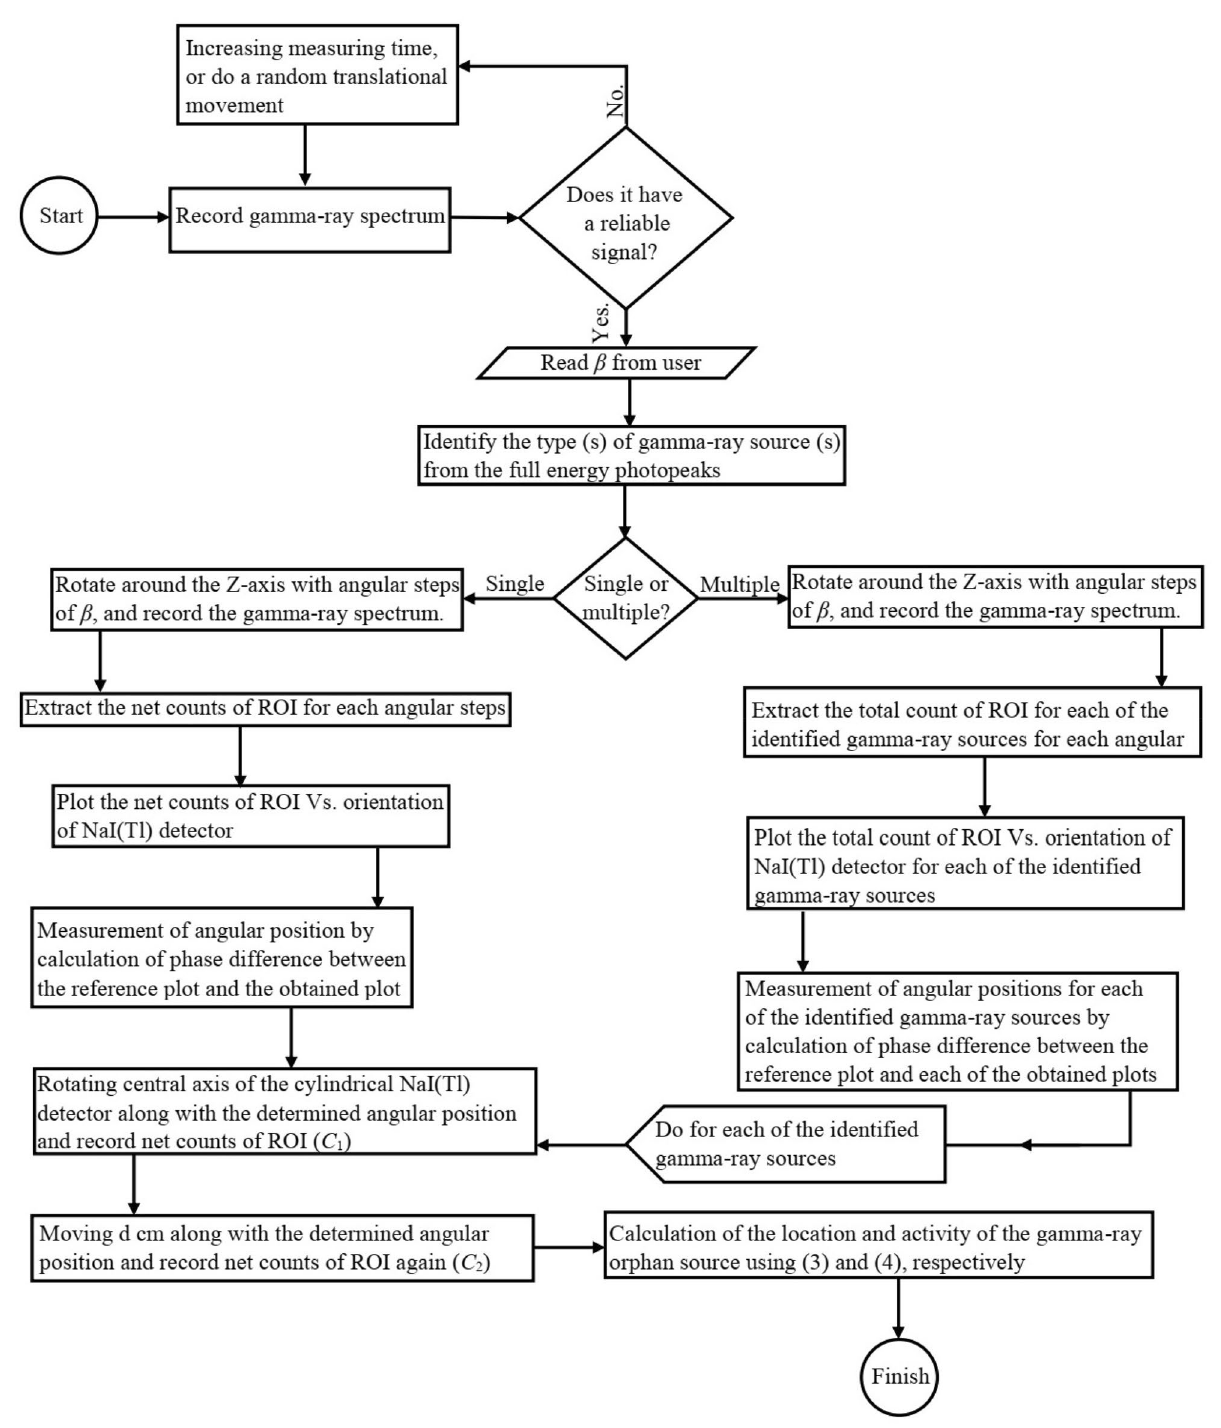
Figure 6. Flowchart of the procedure of finding orphan gamma-ray